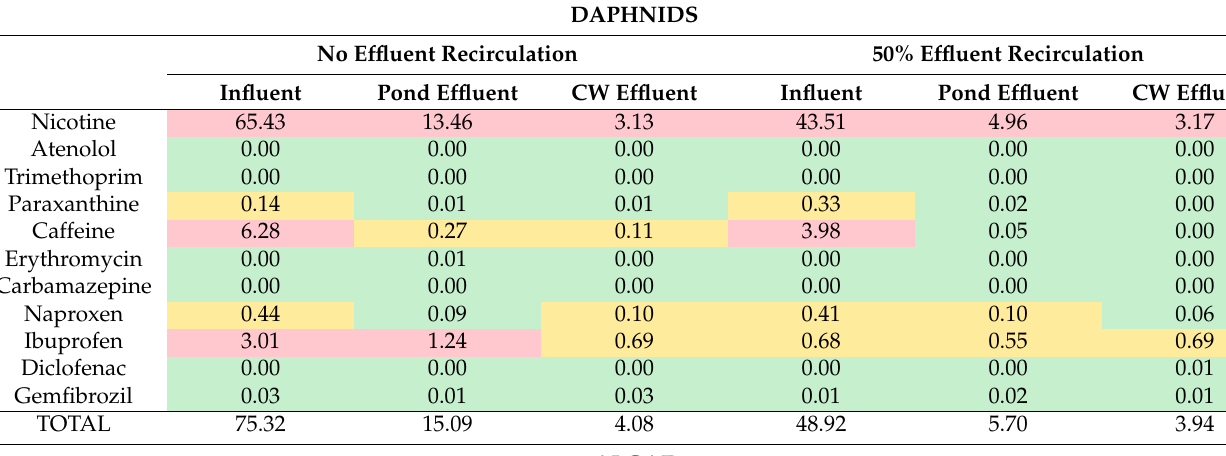
Table 1. Risk quotients (RQs) of the target pharmaceuticals for daphnids and algae in the different studied points with and without effluent recirculation. Red cells: high ecological risk, yellow cells: medium ecological risk, green cells: low ecological risk. DAPHNIDS